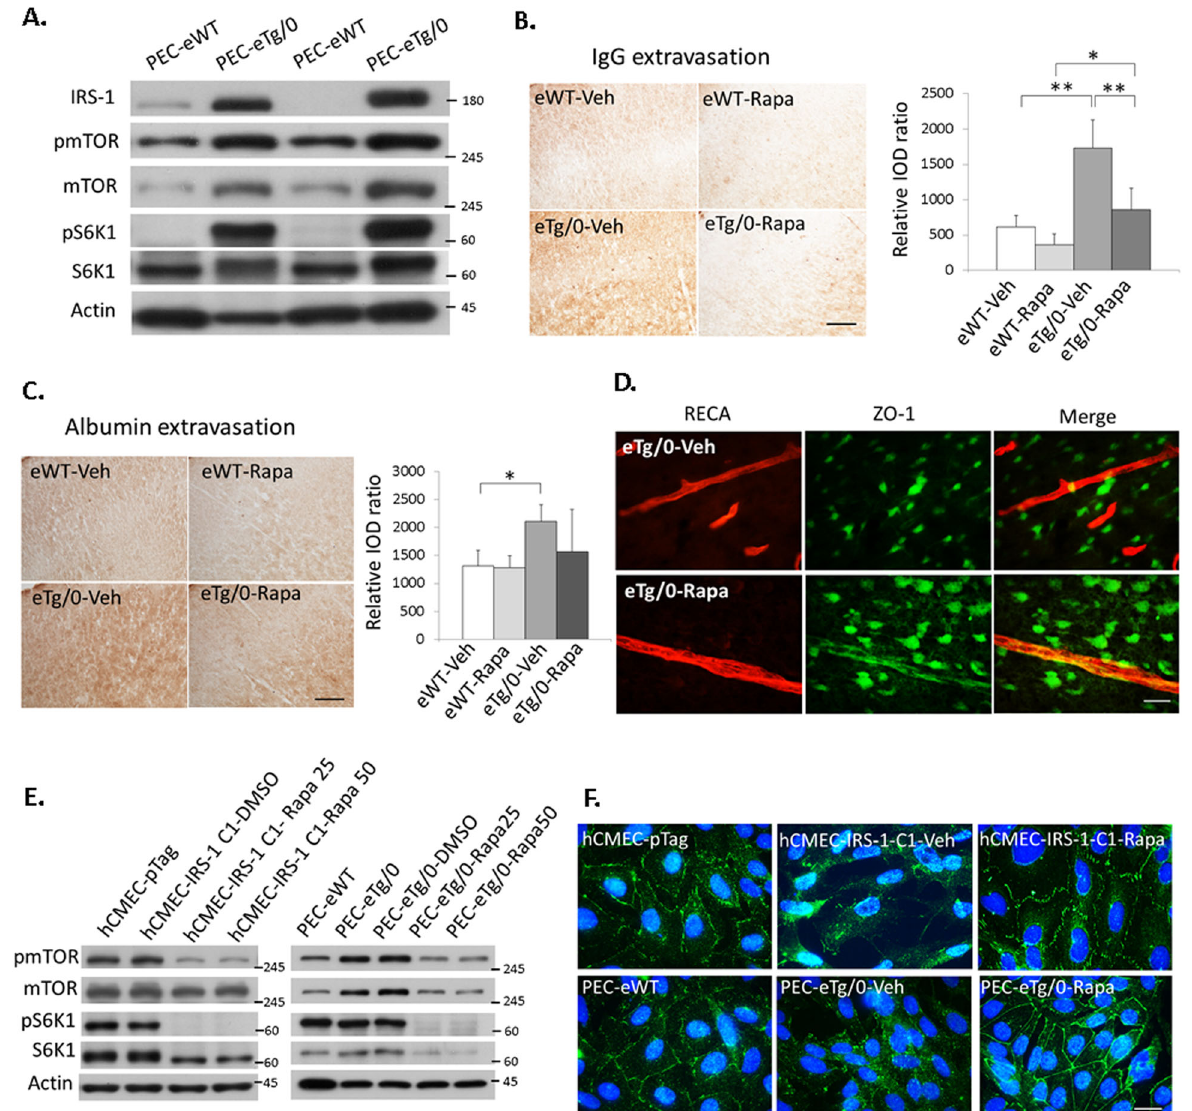
Fig. 5 mTOR inhibition reversed the disturbed barrier functions induced by endothelial IRS-1 overexpression. ( A ) The primary endothelial cells from eTg/0 pups (PEC-eTg/0) had higher protein levels of phospho-mTOR (pmTOR), mTOR, phospho-S6K1(pS6K1), and S6K1at basal state (on P7 before HI) than the primary endothelial cells from eWT pups (PEC-eWT) (N = 6). ( B, C ) Representative images illustrate IgG and albumin extravasation at 24 h after HI in the cerebral cortex of eTg/0 and eWT treated with rapamycin (Rapa) or vehicle (Veh), respectively. The relative integrated optic density (IOD) of IgG and albumin signals was quanti fi ed. N = 6, Scale bar: 125um. One-Way ANOVA (Scheffe ’ s post-hoc test) was used for statistical analysis (b: F value = 29.083; c: F value = 4.567). All data are presented as mean ± SD. * P < 0.05, ** P < 0.001. ( D ) Rapamycin increased ZO-1 expression in the RECA ( + ) vessels in the eTg/0 rats compared to vehicle. Scale bar: 25um. N = 3 ( E ) The expression levels of pmTOR and pS6K1 were suppressed by 25 nM or 50 nM rapamycin in the IRS-1 overexpressed hCMEC clone (hCMEC-IRS-1 C1) (left panel, N = 4) and the PEC-eTg/0 (right panel, N = 4). ( F ) Representative images illustrate the disassembled distribution of ZO-1 in the cytoplasm induced by IRS-1 overexpression in the hCMEC-IRS-1 C1 and the PEC-eTg/0. The distribution of ZO-1 became assembled in the cell membrane by rapamycin (50 nM) treatment. Scale bar: 25 μ m. N =